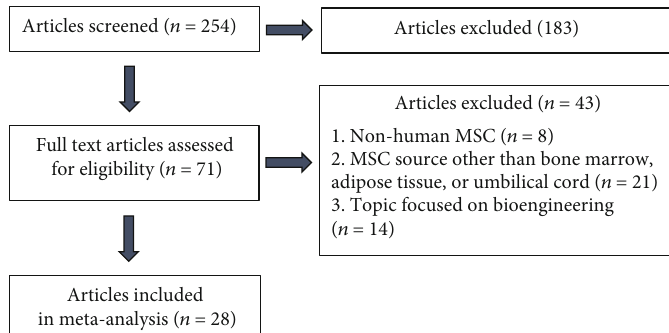
Figure 1: Meta-Analysis Study